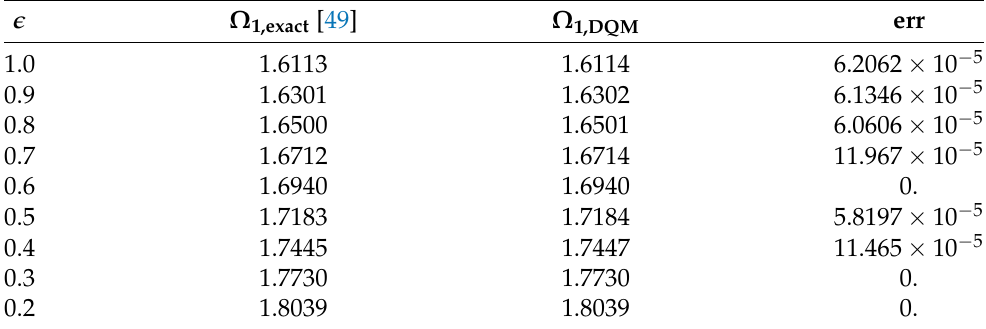
Table 2. Comparison of the first dimensionless frequency Ω 1 from the exact solution [49] and DQM for different (cid:101) . The other parameters are q 1 = 2, q 2 = 2, η = 0, λ = 0, K R = 0, and K T = 0.